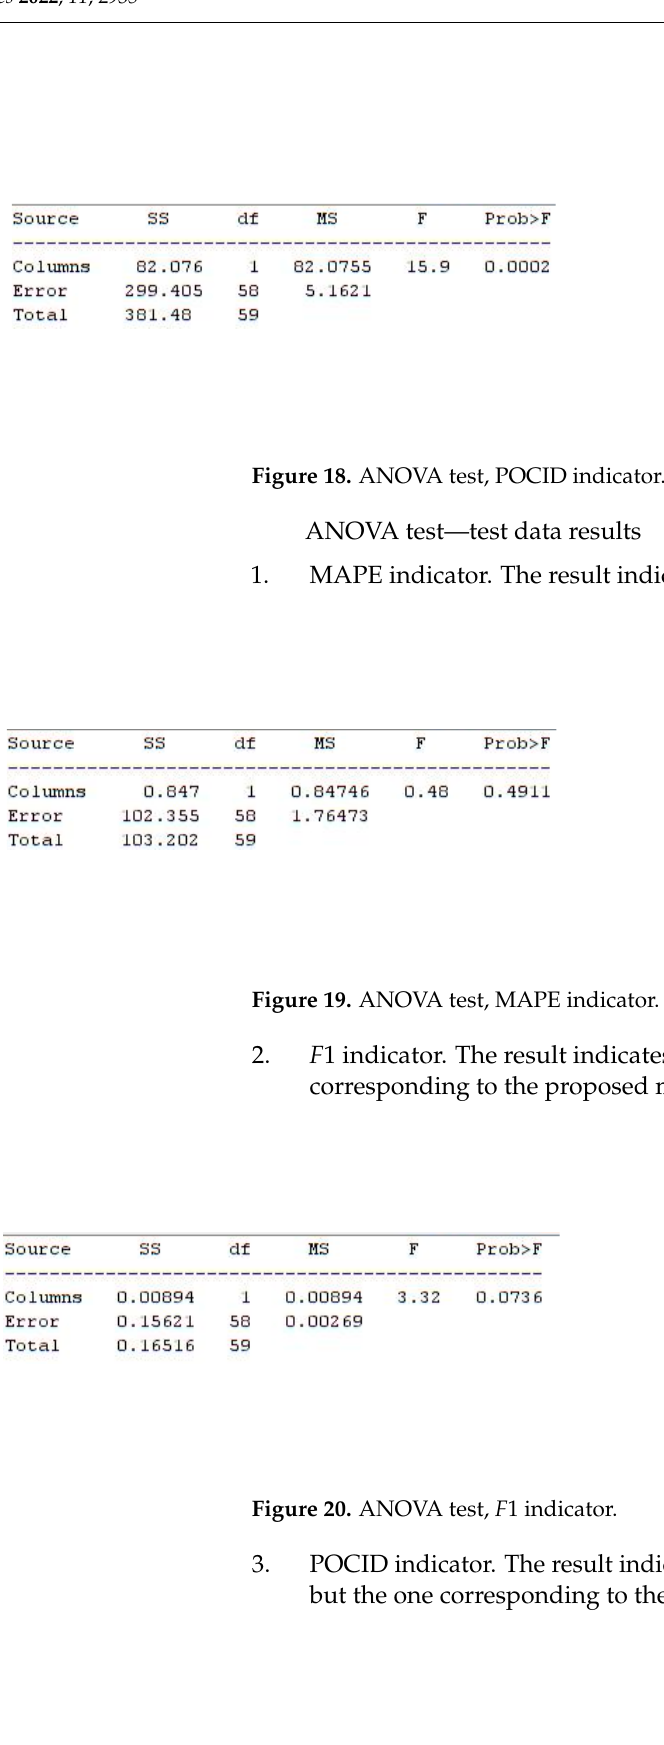
Figure 17. ANOVA test, F 1 indicator.